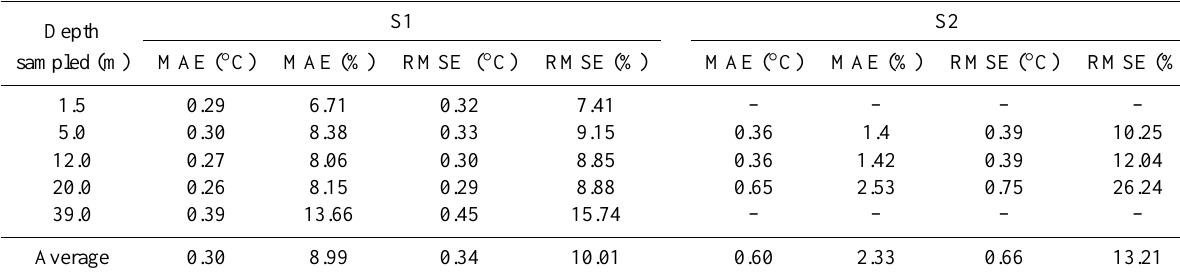
Table 3. MAE and RMSE of the simulated temperature at the S1 and S2 stations.